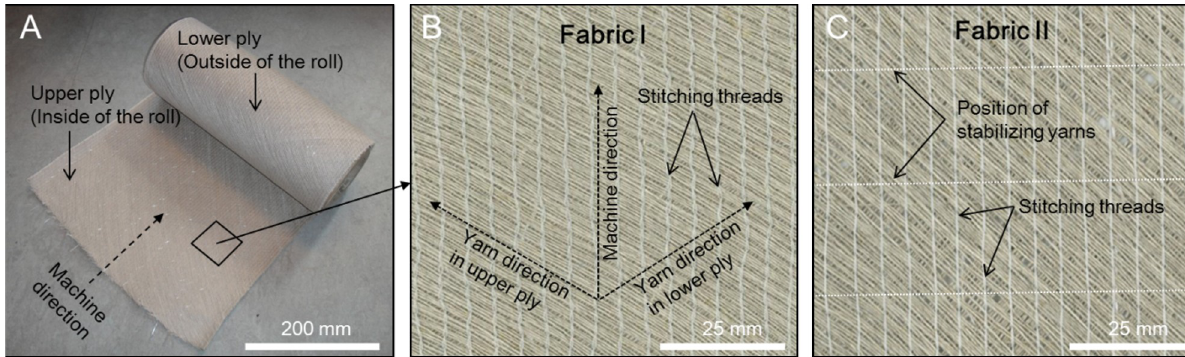
Fig 1. Photographs of the used non-crimp biaxial flax fibre fabrics. A: Roll with width of 330 mm. B, C: Magnified view of fabric I and fabric II.